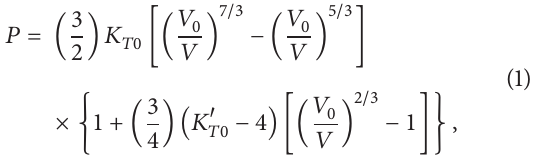
Table 2: Cell parameters versus pressure for Mg